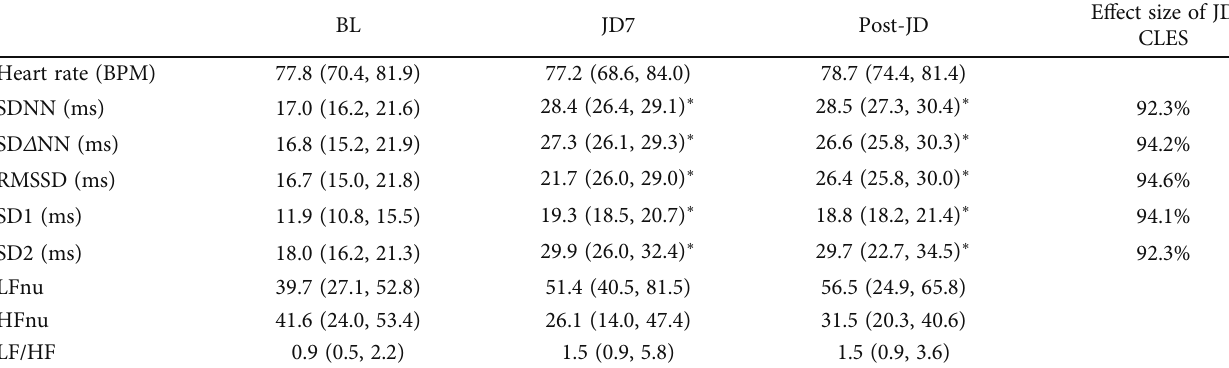
Table 2: E ff ects of JD on parameters of heart rate